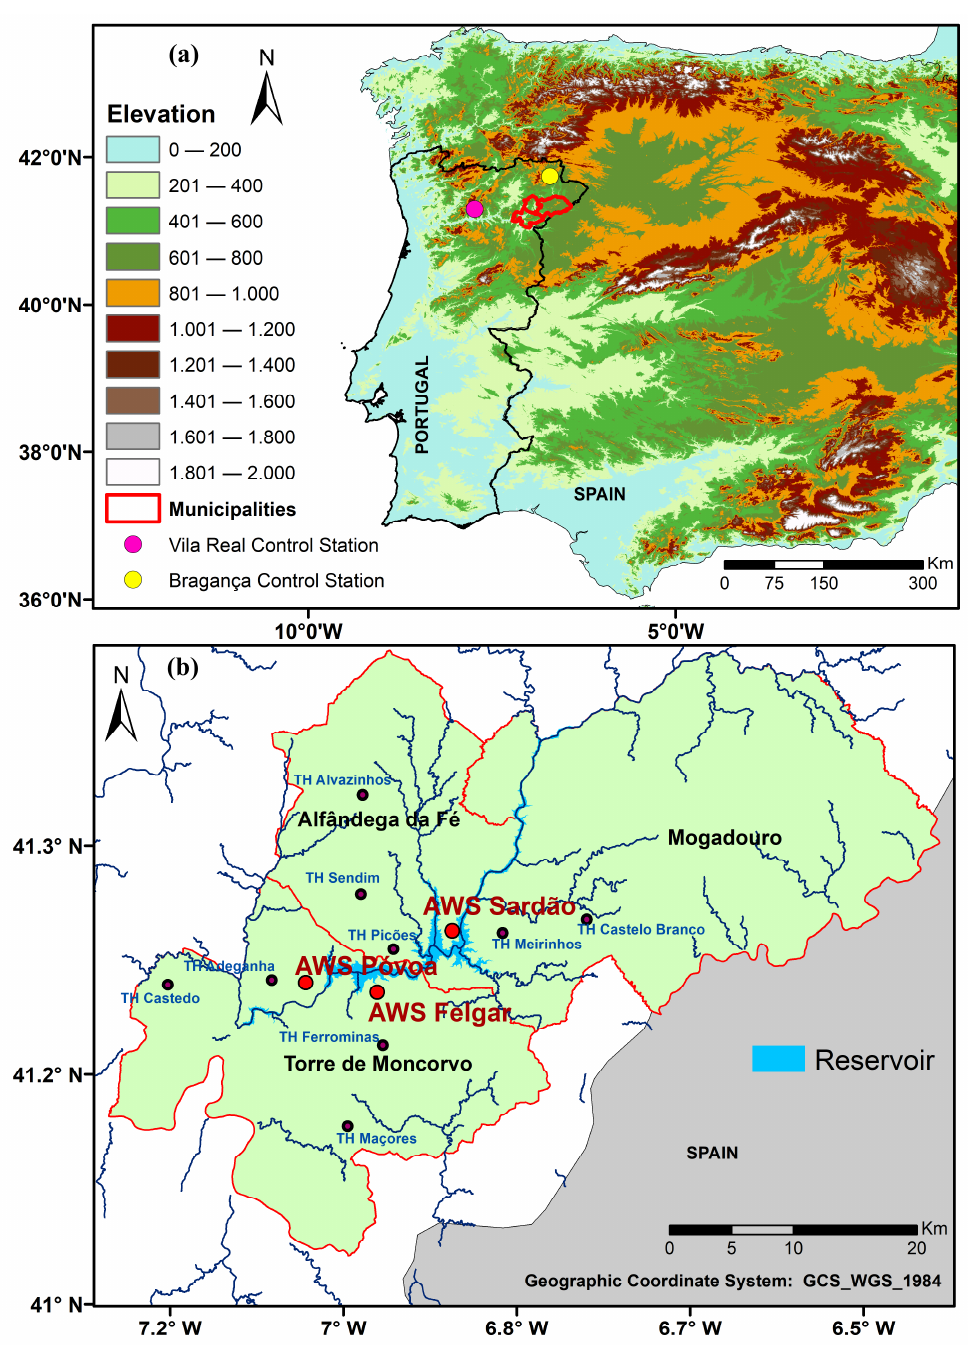
Figure 1. ( a ) Geographical location of the municipalities of the reservoir area (target area) from the Baixo Sabor Hydroelectric Plant (BSHP), and the location of the Vila Real Control Station; ( b ) location of the three automatic weather stations (AWS), P ó voa, Felgar, and Sard ã o, and of the six thermohygrometric automatic stations (TH) within the target